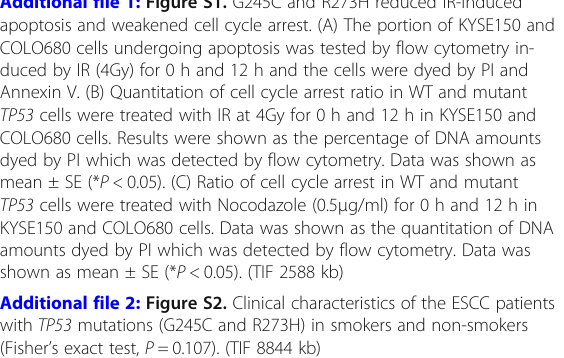
Additional file 2: Figure S2. Clinical characteristics of the ESCC patients with TP53 mutations (G245C and R273H) in smokers and non-smokers (Fisher ’ s exact test, P = 0.107). (TIF 8844